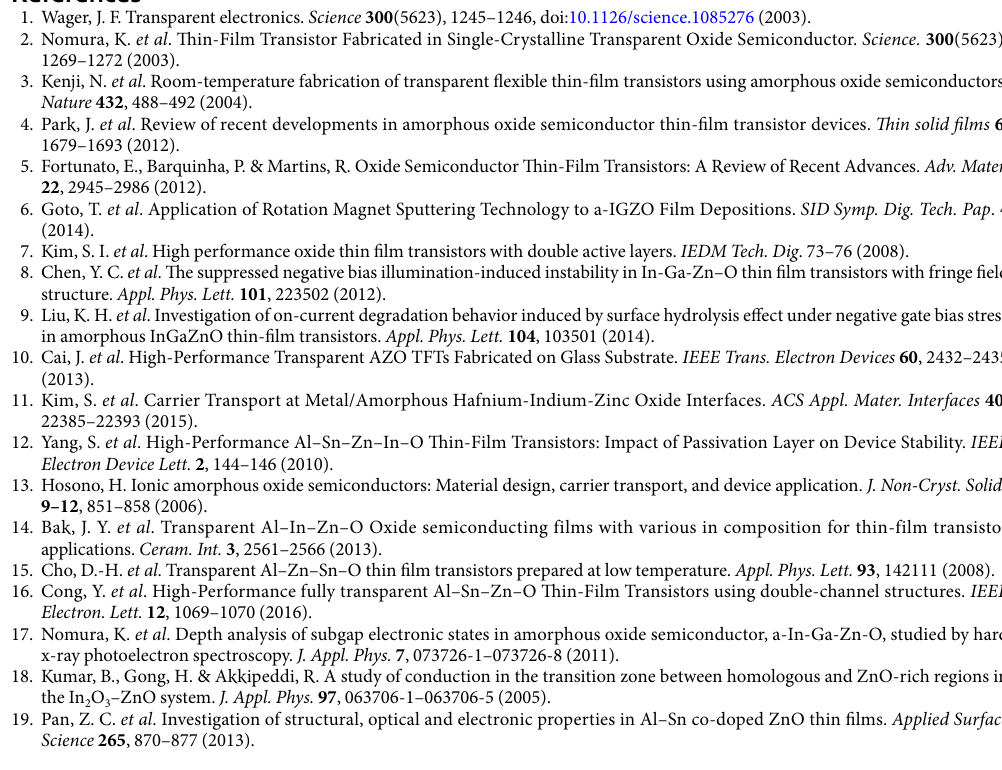
5 Scientific RepoRts | 7: 1497 | DOI:10.1038/s41598-017-01691-7